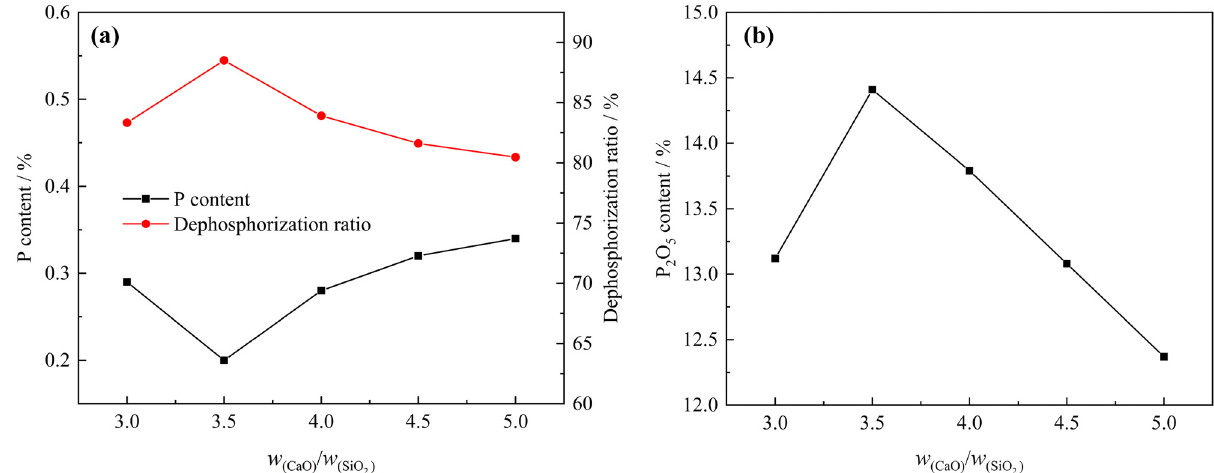
Figure 2: E ff ect of basicity on the P content of the fi nal metal and the P 2 O 5 content of the high - P - containing slag: ( a ) P content and dephosphorization ratio and ( b ) P 2 O 5